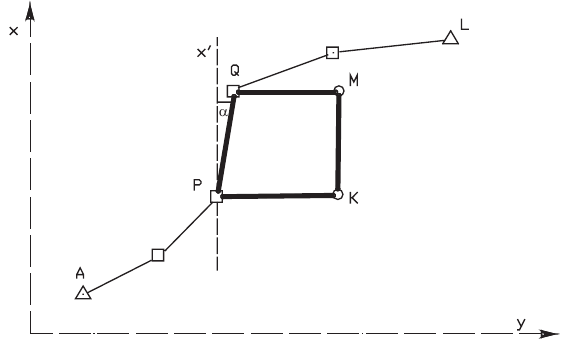
Fig. 1. Connecting traverse and building site